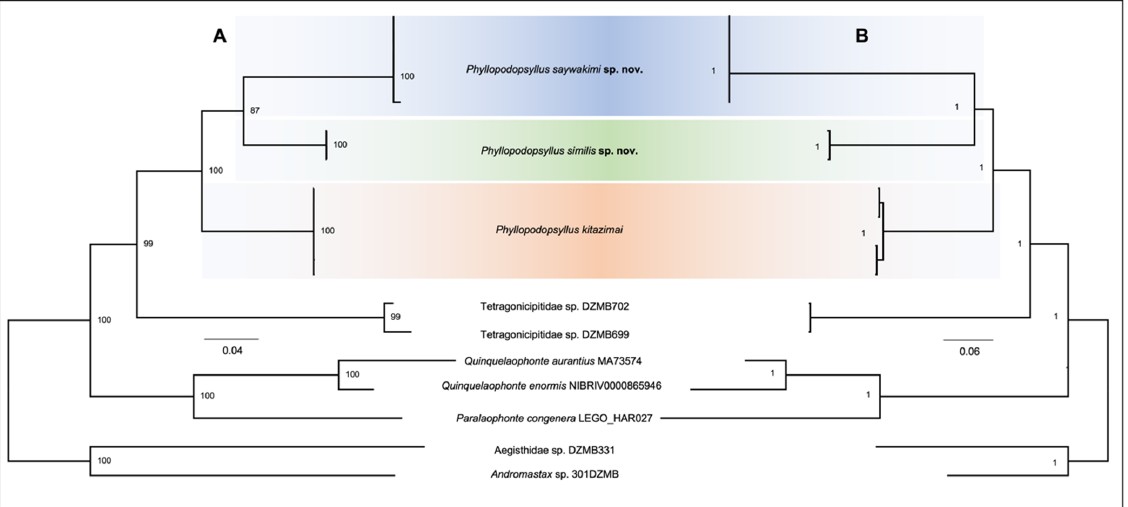
Figure 38. The two rooted trees of three Korean Phyllopodopsyllus species and some harpacticoids based on 18S rDNA, 28S rDNA, and cox1: ( A ) Maximum likelihood tree; ( B ) MCC tree. Numbers on each node are bootstrap values in ( A ) and posterior probabilities in ( B ). Scale bars: substitutions per site.